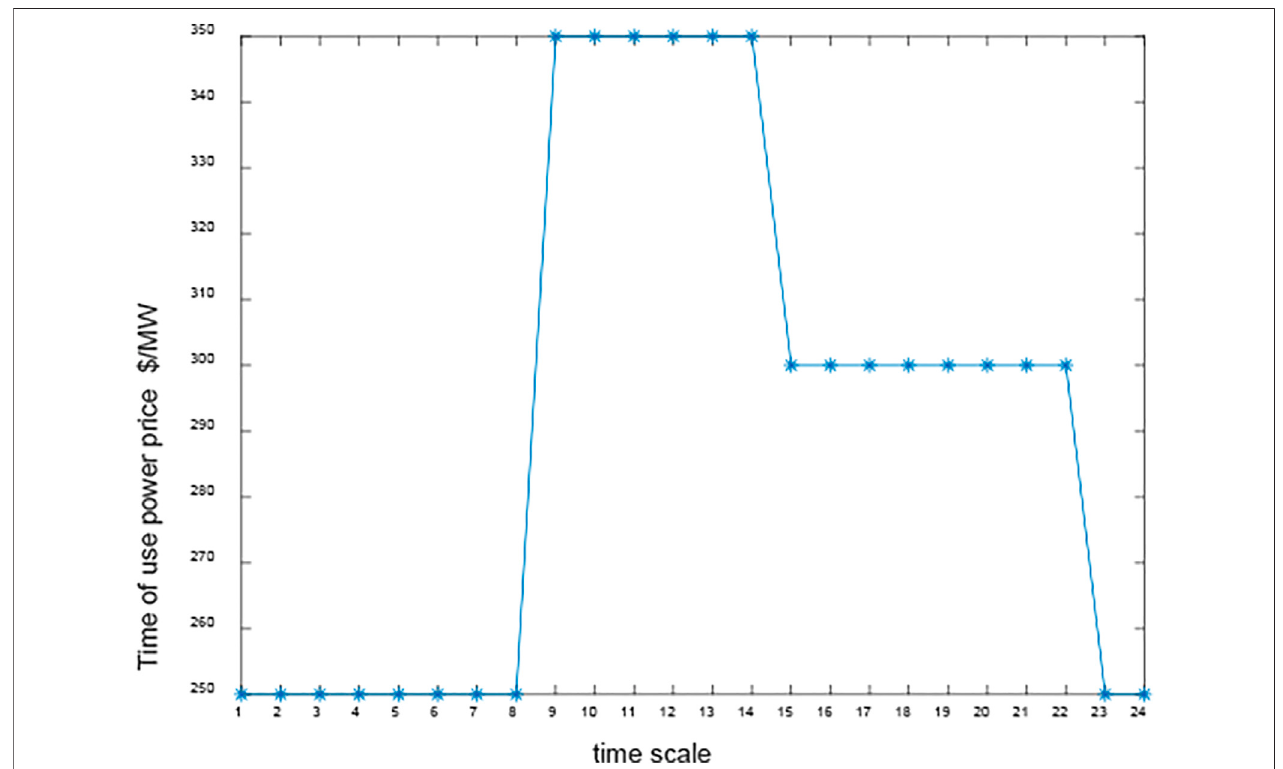
FIGURE 7 | Time-of-use electricity